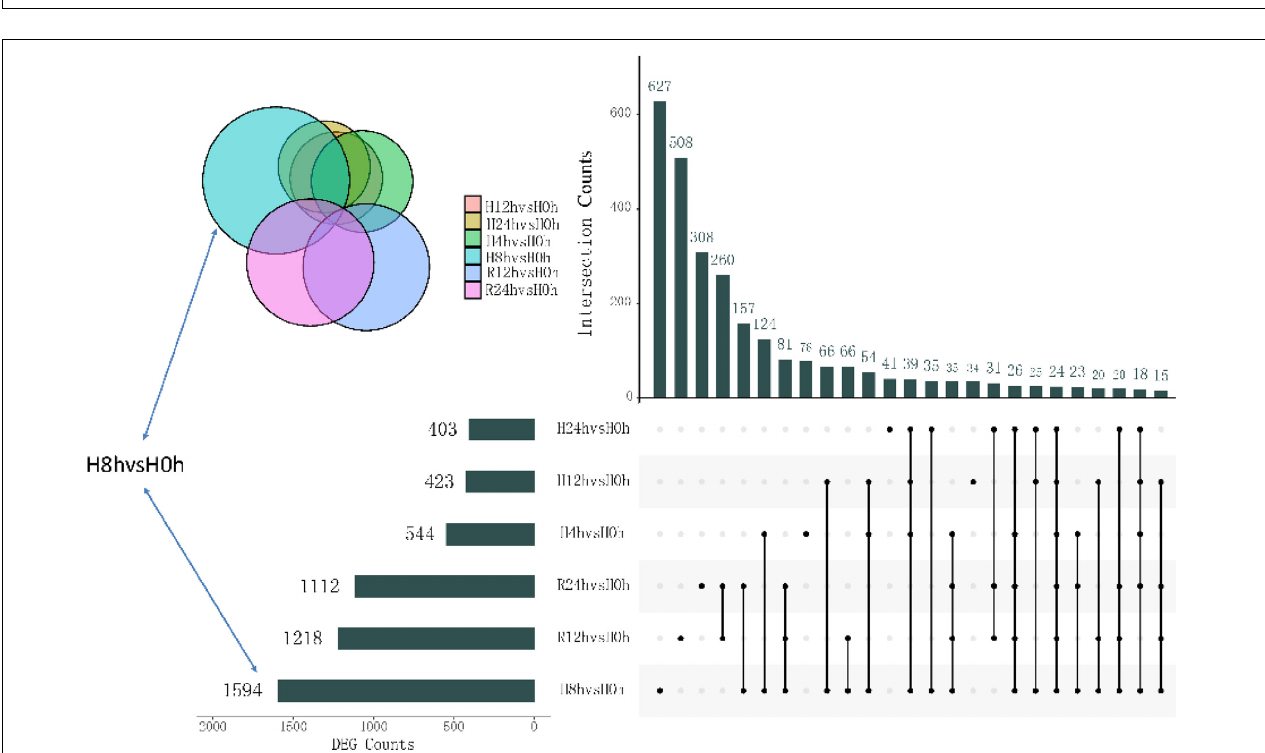
FIGURE 2 | Upset diagram showing the unique and shared DEGs of different hypoxic stress time.